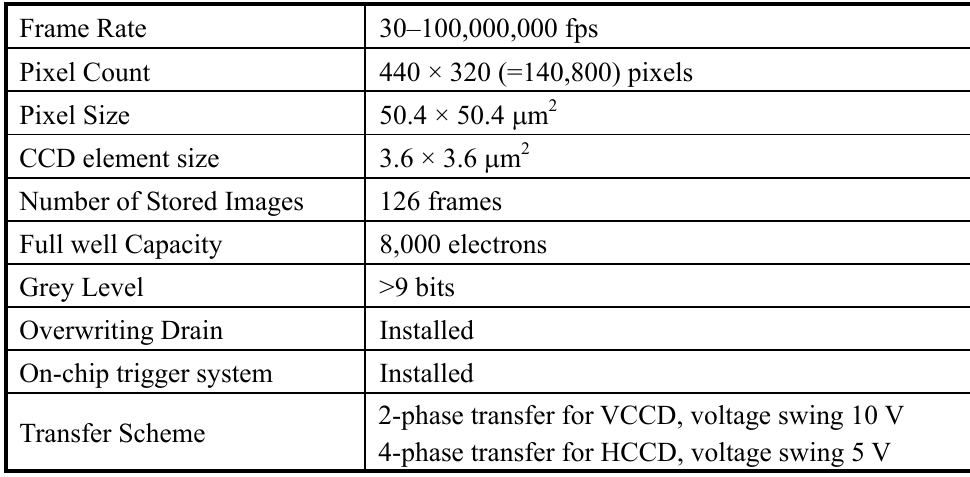
Table 2. Design specification of the